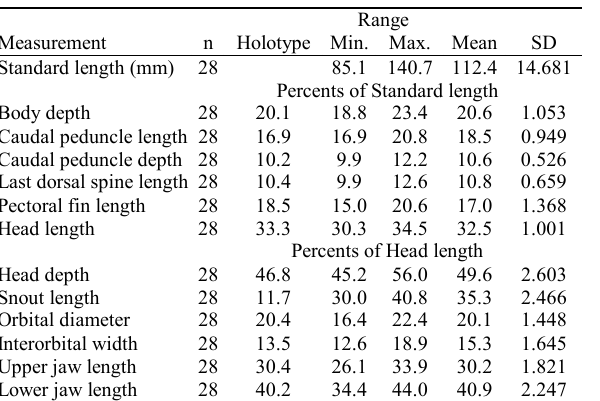
Table 4 . Frequency counts of meristic characters of Crenicichla empheres . MCP 13585, *=Holotype. Dorsal fin spines